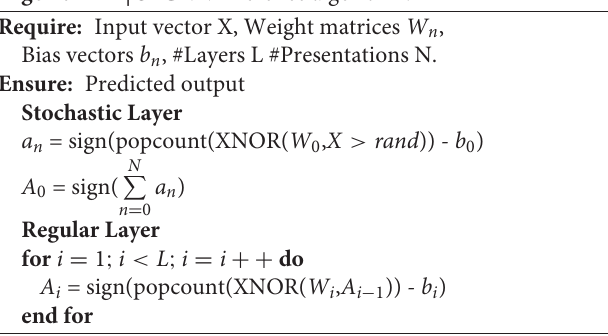
Algorithm 1 | SBCNN inference